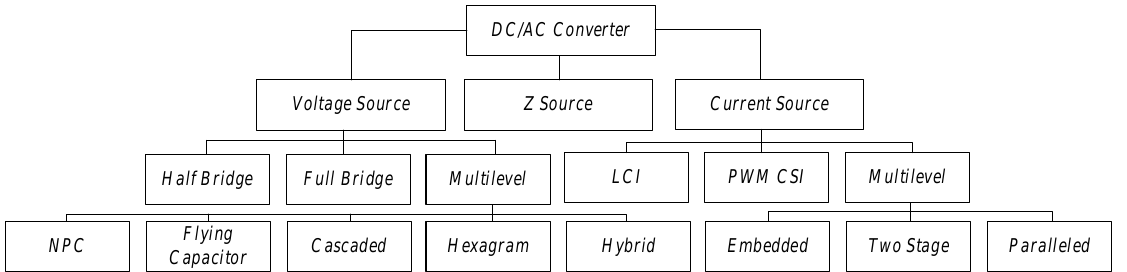
Figure 2. DC/AC converters classification